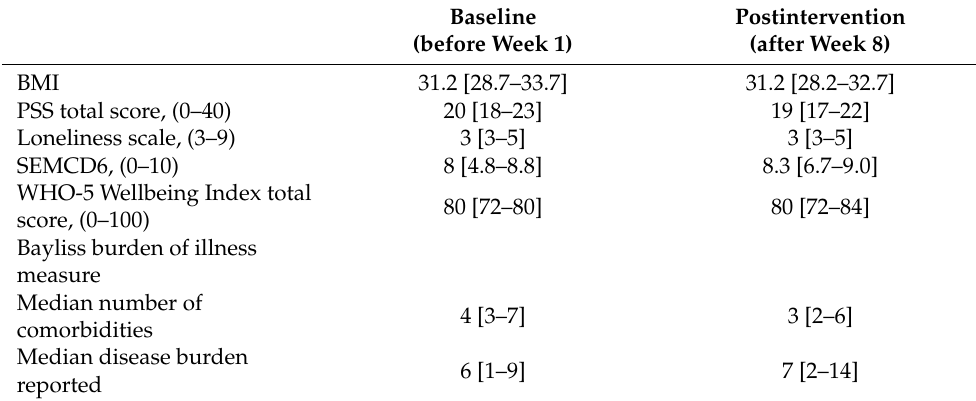
Figure 4. Raincloud plot representing an illustration of data in a half-density distribution (the ‘cloud’) with individual raw data (the ‘rain’) and a boxplot below the ‘cloud’ of the total daily steps at baseline, midway, and post-intervention. Table 5. Secondary self-reported